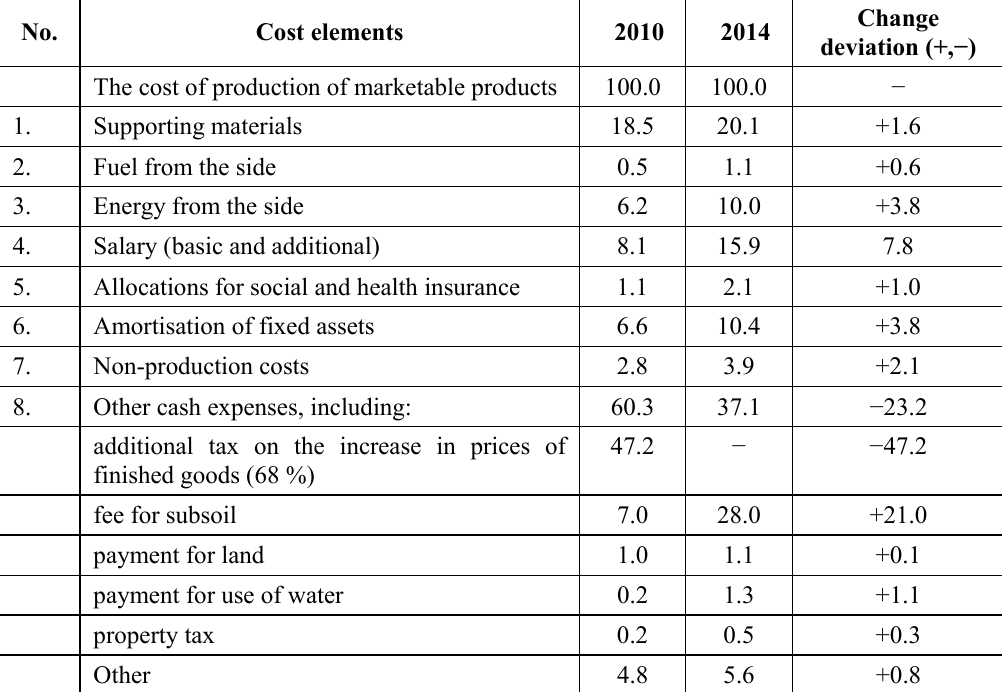
Table 2. The Structure of the Production Costs of the Mining Enterprise Erdenet, % (made by the authors based on the data by LLC Erdenet, 2015)